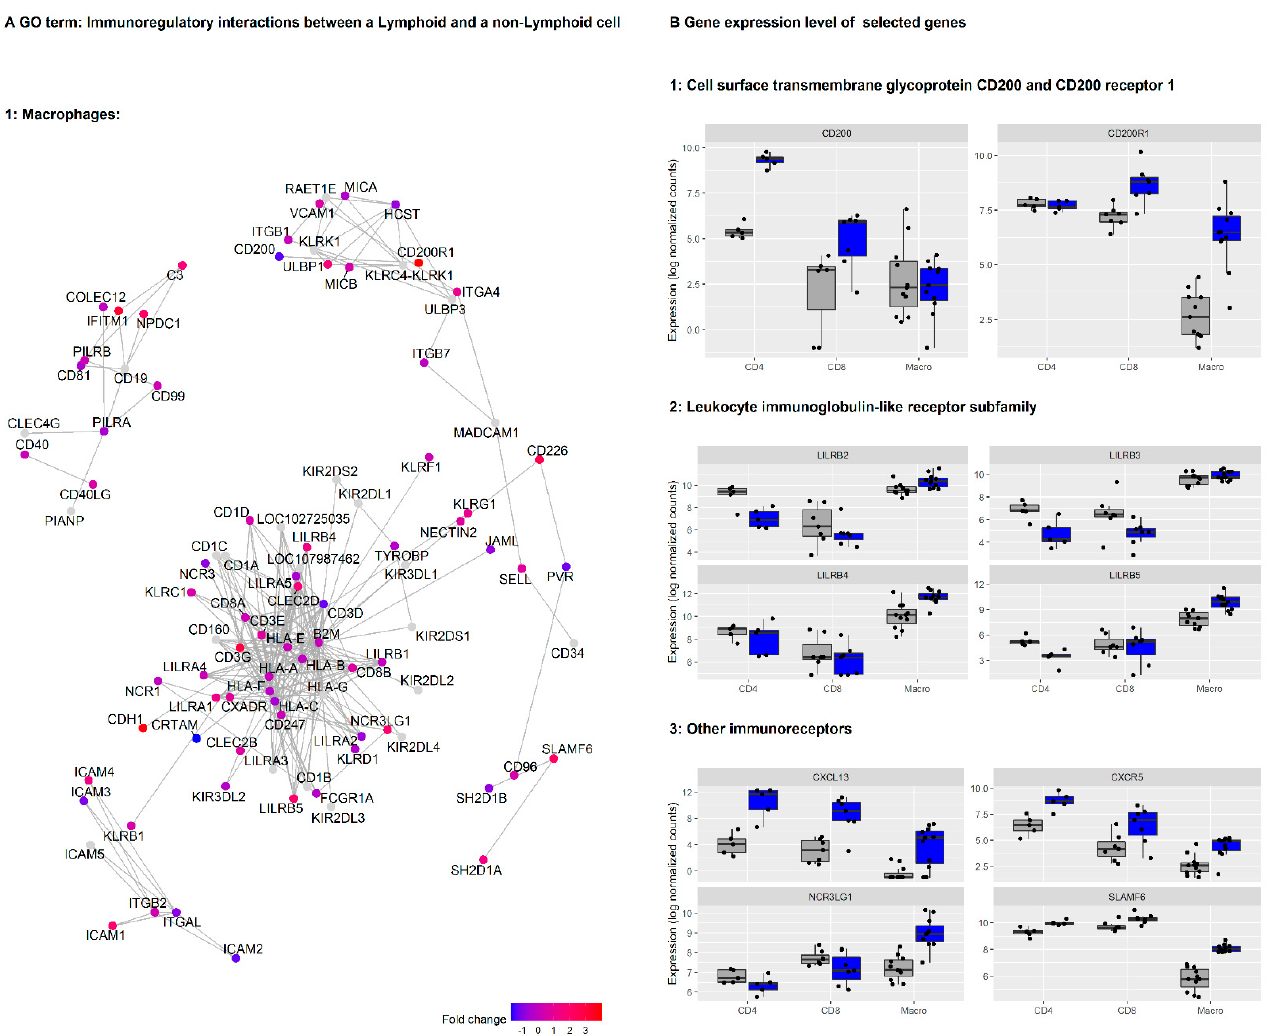
Figure 4. Cell surface transmembrane glycoprotein CD200 and its receptor CD200R1, and members of the Leukocyte immunoglobulin-like receptor subfamily (LILRs) are dysregulated in the tumor microenvironment (TME) in NSCLC. Legend: ( A ) the gene-network plot shows expression (log2 fold change) of genes in the GO term ‘Immunoregulatory interactions between a lymphoid and a nonlymphoid cell’ for macrophages, CD4 + and CD8 + T cells. In a gene-network plot (cnet plot in the Bioconductor package clusterProfiler), the genes are interconnected based on linkages of genes in networks based on biological functions. ( B ) 1: CD200 and its receptor CD200R1, and 2: members of the LILRs are DE in macrophages, CD4 + and CD8 + T cells from tumor compared to lung tissue. 3: Gene expression profiles of other immunoreceptors are displayed. These ligand/receptors may represent important pathways for immunosuppressive signals from TAMs to CD4 + or CD8 + T cells in the TME.